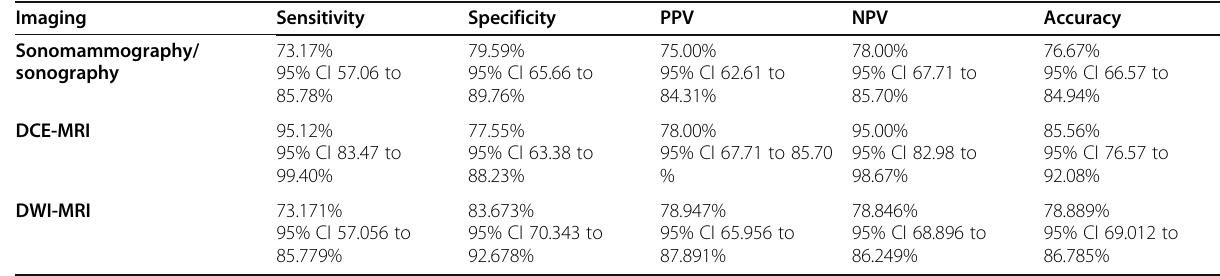
Table 5 Diagnostic indices and accuracy measures of mammography and/or sonography, DCE-MRI, and DW-MRI